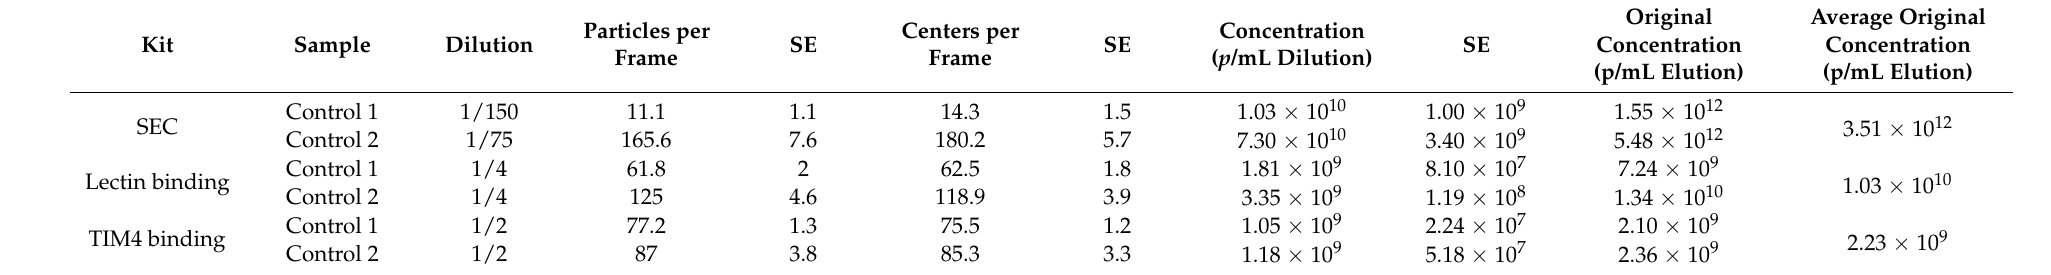
Figure 1. Size distribution of exosomes extracted using 3 different commercial kits. ( A ) SEC with peak size of 201 nm. ( B ) Lectin binding with peak size of 99 nm. ( C ) TIM4 binding with peak size of 133 nm. Table 1. NanoSight results for 2 replicates of each exosome extraction method.